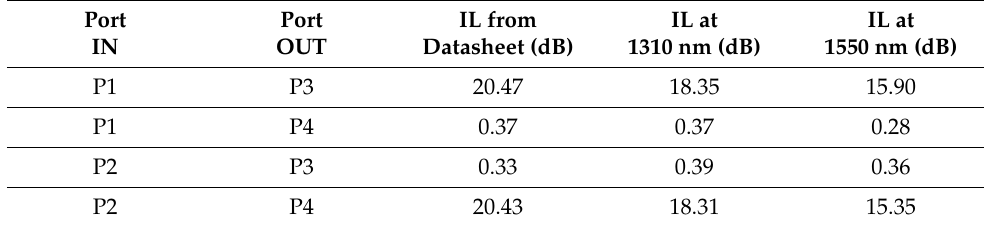
Table 6. Insertion loss of the coupler 99:1 measured with OTDR method.